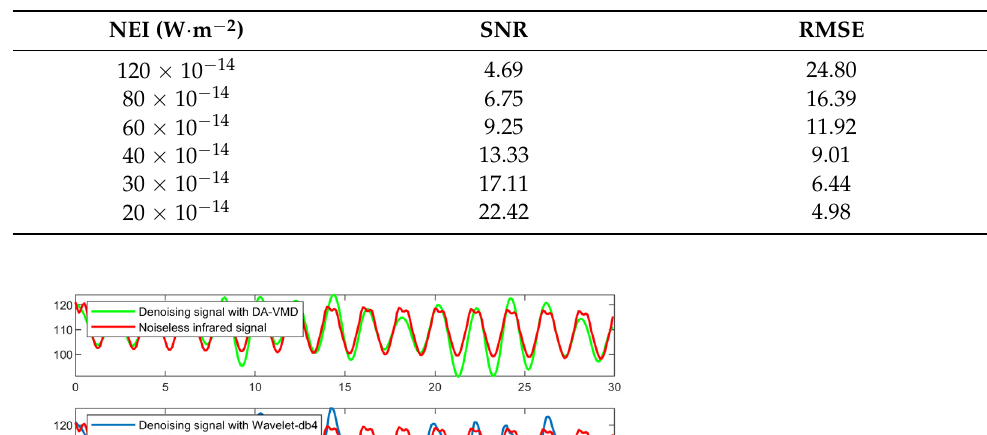
Table 6. The corresponding relationship between SNR, RMSE of radiation intensity, and NEI.